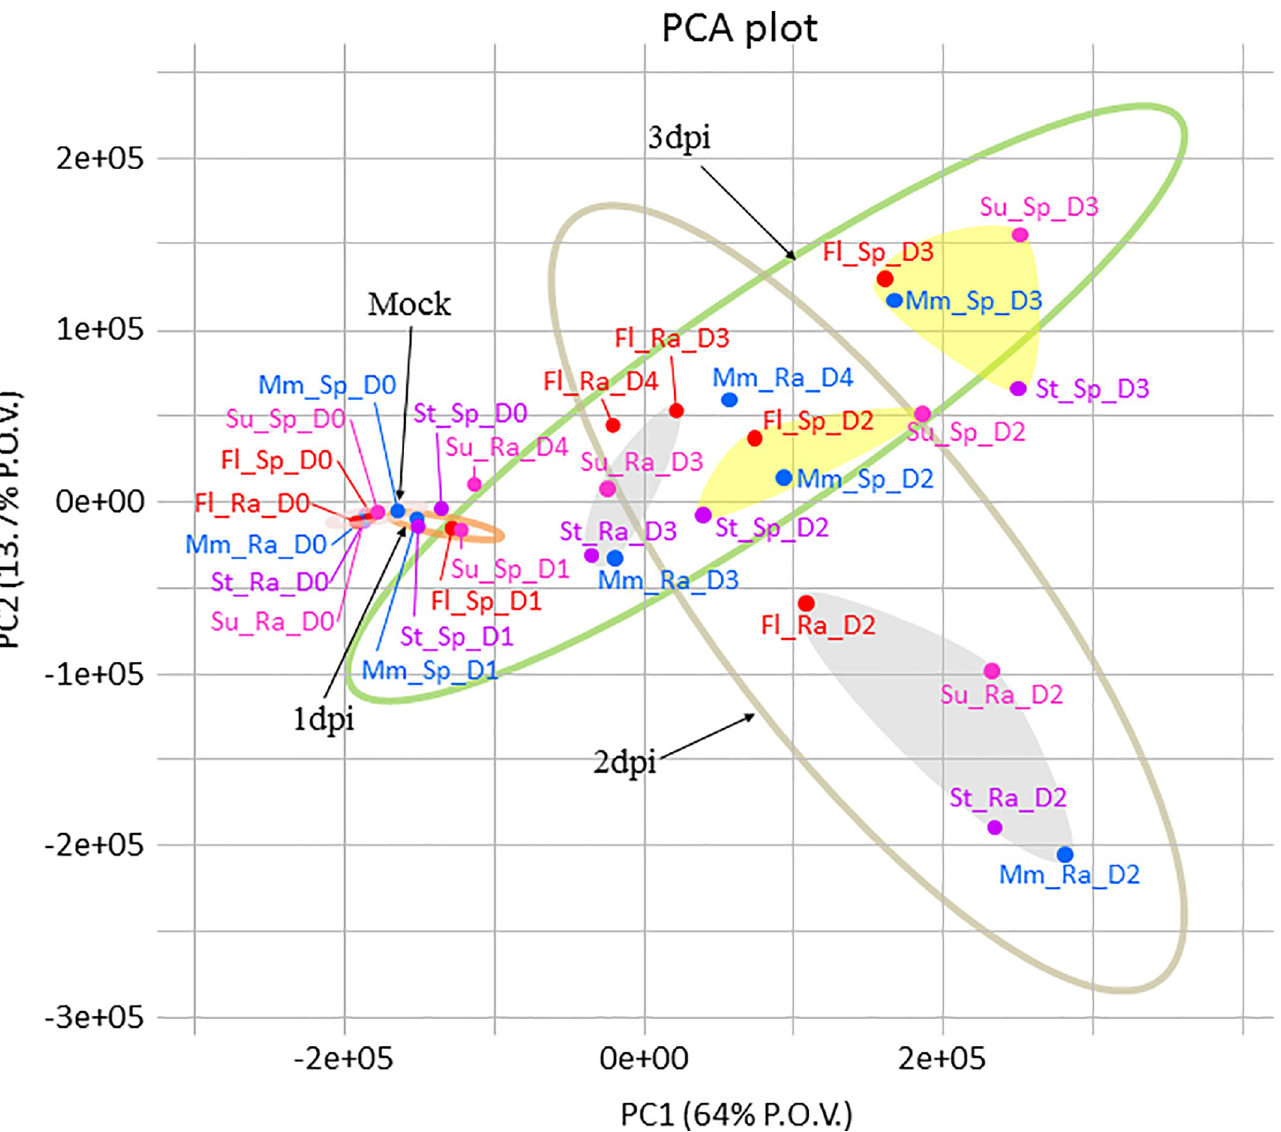
Fig 2. Principal component analysis of the transcriptomes of the two organs from each variety at each time point. Principal component analysis (PCA) was performed using the prcomp function from the R base package. Ellipses (confidence level = 0.9) are graphical representations of samples at different dpi. Light yellow areas indicate spikelet-based transcriptomes; grey areas indicate rachis-based transcriptomes. Coloured ovals indicate different time points. Ra, Rachis; Sp, Spikelet; D,